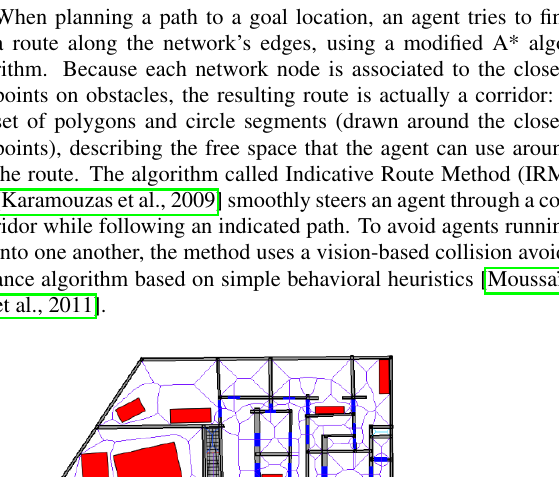
Figure 6: 3D view of evacuation simulation and social